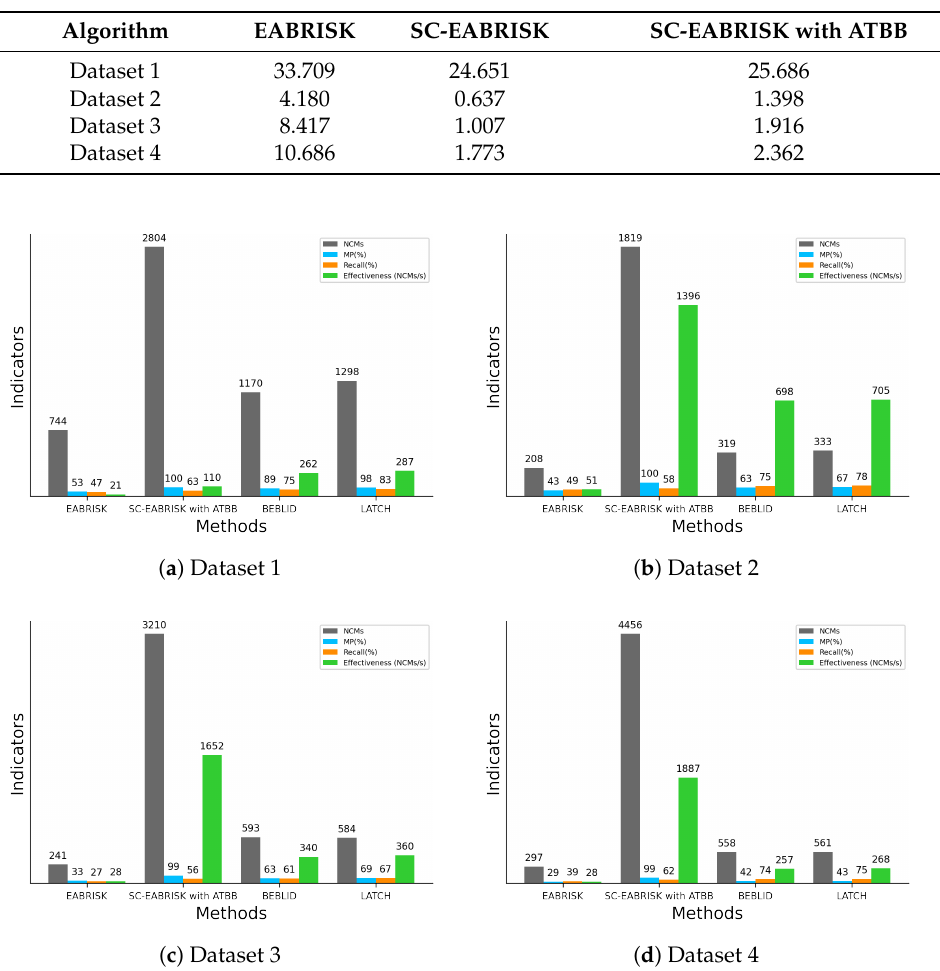
Table 2. Comparisons of the TC (seconds) by using the benchmark imagery datasets with different al- gorithms.